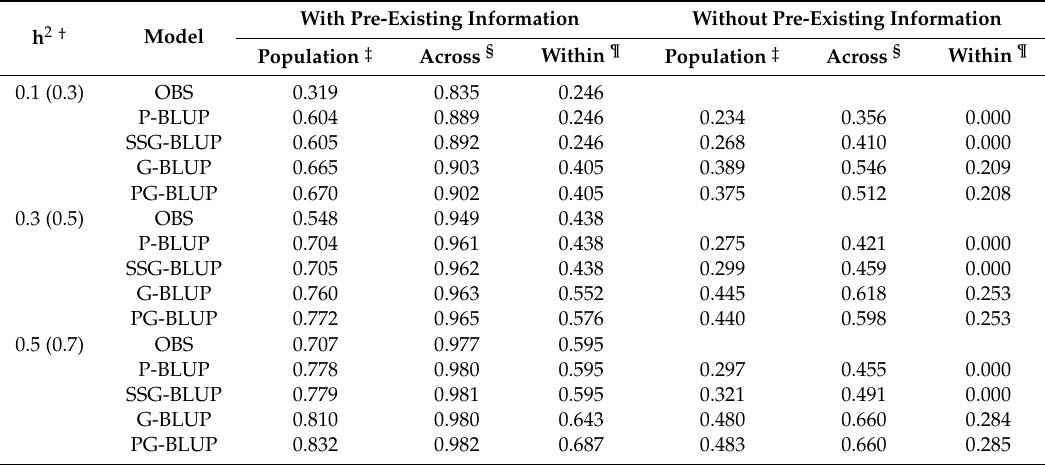
Table 2. Comparison of the prediction accuracies for di ff erent validation metrics in the simulation using only phenotypic (OBS), pedigree (P-BLUP), single-step (SSG-BLUP), genomic (G-BLUP) or pedigree-genomic (PG-BLUP) predictions with and without using preexisting information of the selection candidates. With Pre-Existing Information Without Pre-Existing Information h 2 † Model Population ‡ Across § Within ¶ Population ‡ Across § Within